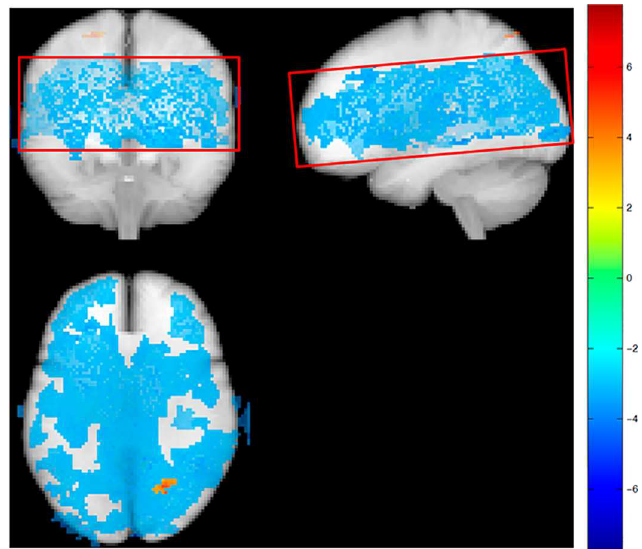
Fig 2. Effect of hemoglobin on regional CBF. Glass brain representation of voxels in absoluteCBF maps with significant(p < 0.001)negativecorrelationwith blood hemoglobin. Brain volume coveredby the ASL measurements is shown in the red